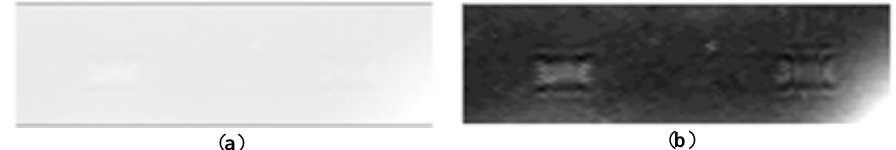
Figure 19. The ( a ) original and ( b ) enhanced images of notches 1 and 2 under the 4 mm-thick rubber layer, obtained at a standoff distance of 0.1 mm.